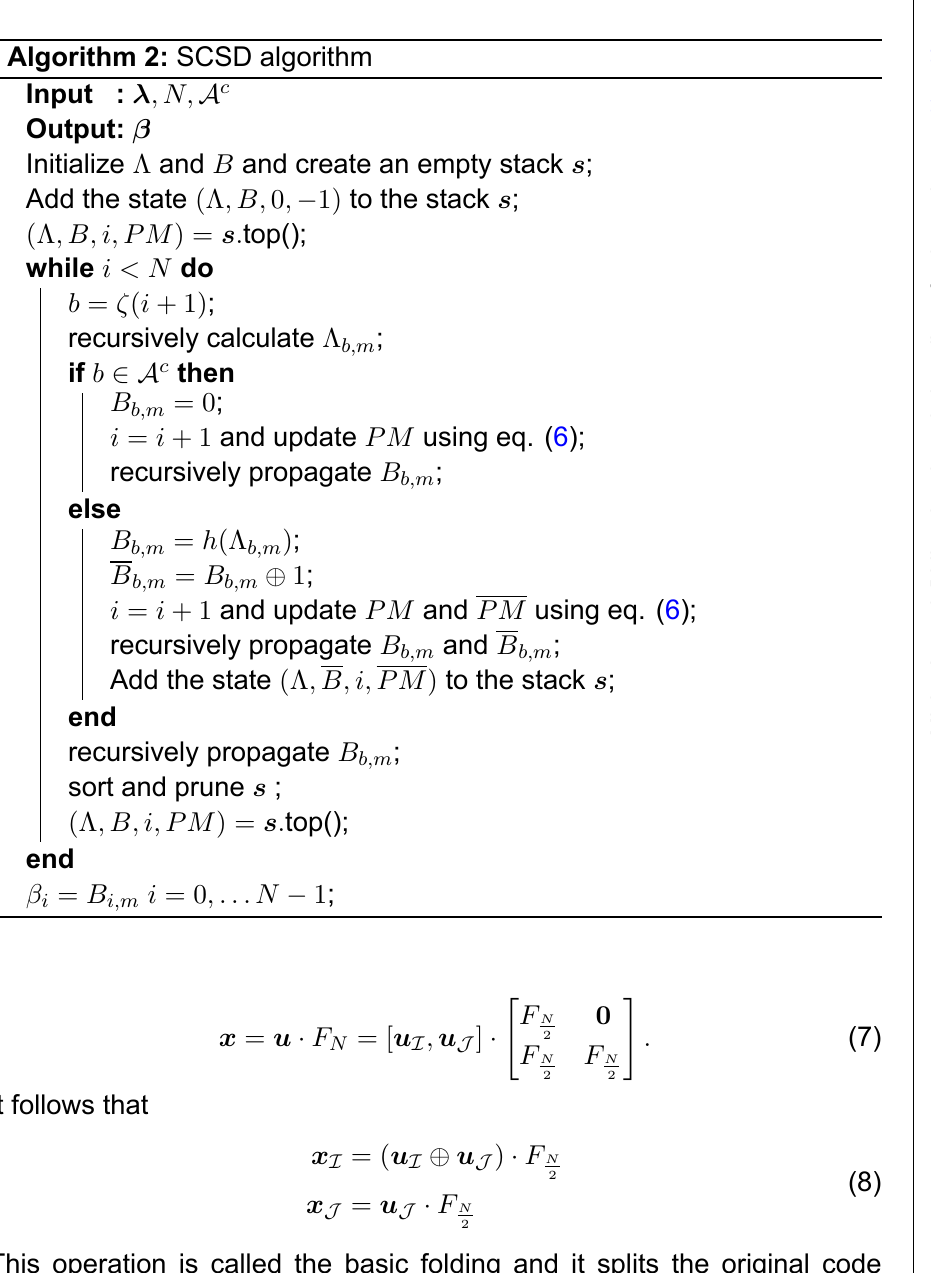
Algorithm 2: SCSD